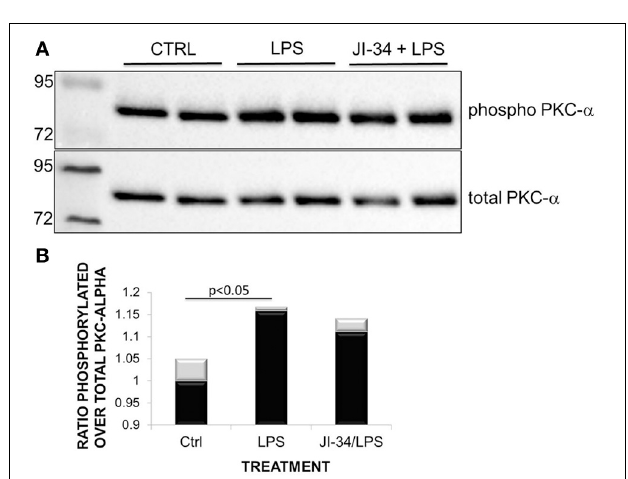
15min with PLY. (B) Representative WB of the Influence of siRNA-mediated PKC- α gene depletion on PLY- and JI-34 induced total PKC activity in HL-MVEC.